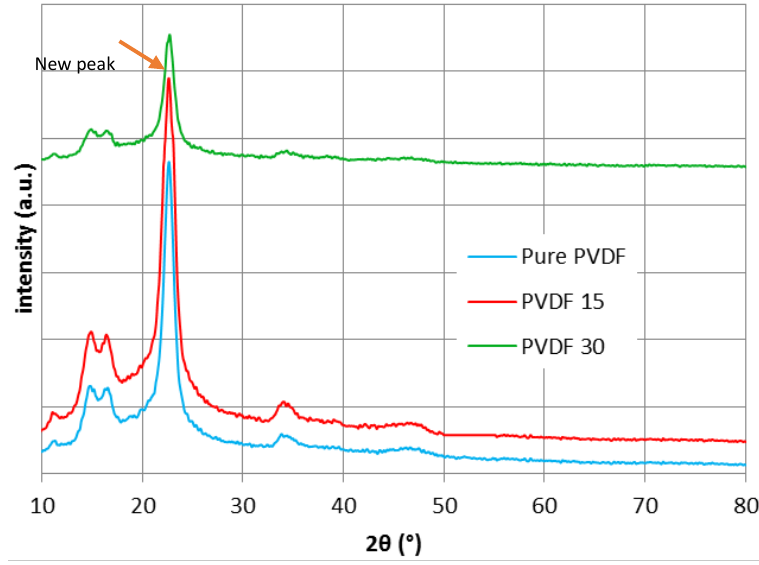
Figure 3. X-ray diffraction (XRD) patterns of ( a ) Pure PVDF; ( b ) PVDF15; and ( c ) PVDF30.